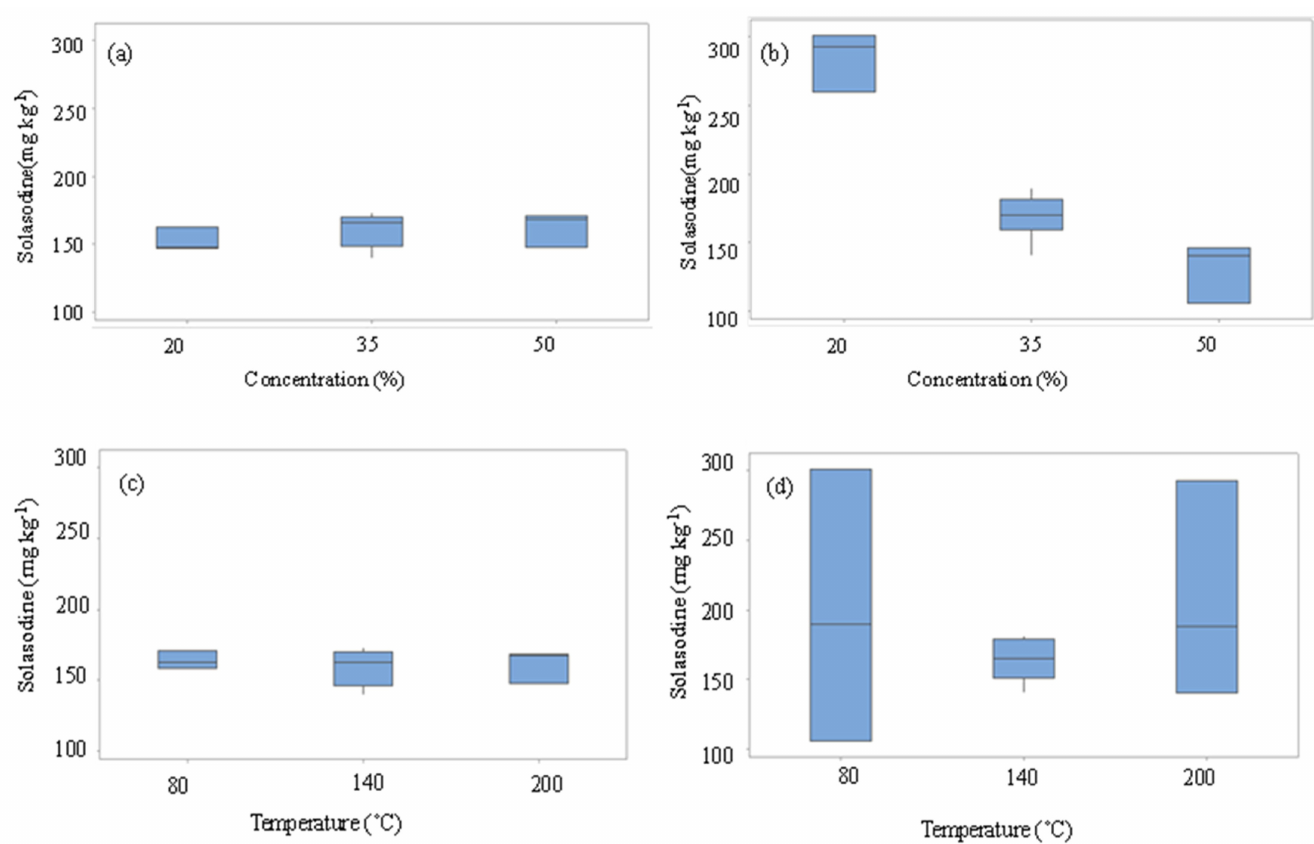
Figure 4. Box-and-whiskers plots evaluating the effect of ‘Concentration of salt on ( a ) NaCl, ( b ) Na 2 CO 3 and the effect of ‘Temperature’ on ( c ) NaCl, and ( d ) Na 2 CO 3 on the extraction of solasodine from leaves of S. mauritianum.